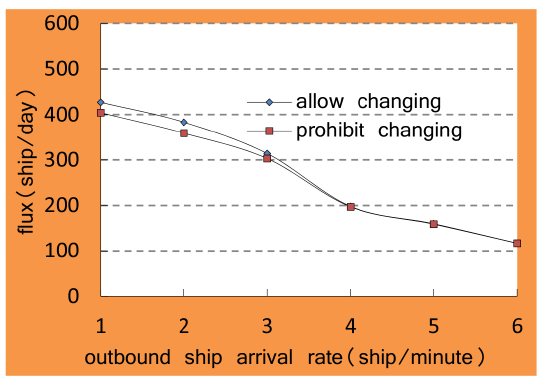
Figure 14. Traffic flux of waterway system and ship arrival rate as a function (inbound ship arrival rate = 3)